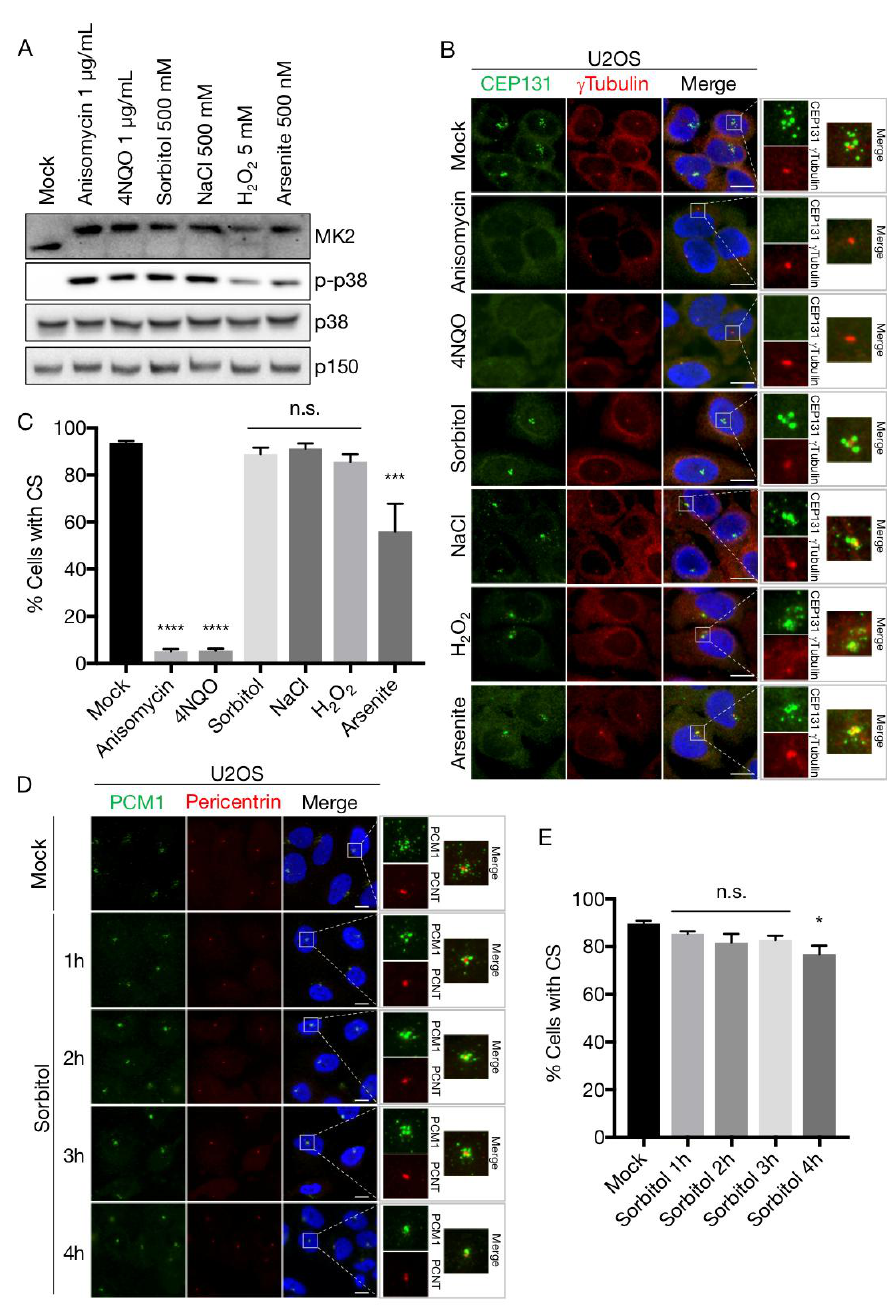
Figure 3. Hyperosmotic conditions protect centriolar satellites from p38-mediated depletion. ( A ) U2OS cells were treated with the indicated stress agents (1 h) and lysates were analysed by immunoblotting with antibodies against phospho-p38, total p38, MK2 and p150 (loading control). ( B ) Cells treated as in ( A ) were immunostained with antibodies against CEP131 and γ-tubulin and counterstained for nuclear content with DAPI. ( C ) Quantification of ( B ). At least 100 cells were scored per condition in 3 independent experiments. Bars indicate the mean +/− SEM. p -values were calculated from a one-way ANOVA using Dunnett’s correction for multiple testing. ( D ) U2OS cells were incubated in the presence of 500 mM sorbitol for the indicated times. Cells were immunostained with antibodies against PCM1 and pericentrin and counterstained for nuclear content with DAPI. ( E ) Quantification of ( D ) performed as in ( C ). *, p < 0.05; ***, p < 0.0005; ****, p < 0.0001, n.s.; not significant. All scale bars, 10 µ m. CS; centriolar